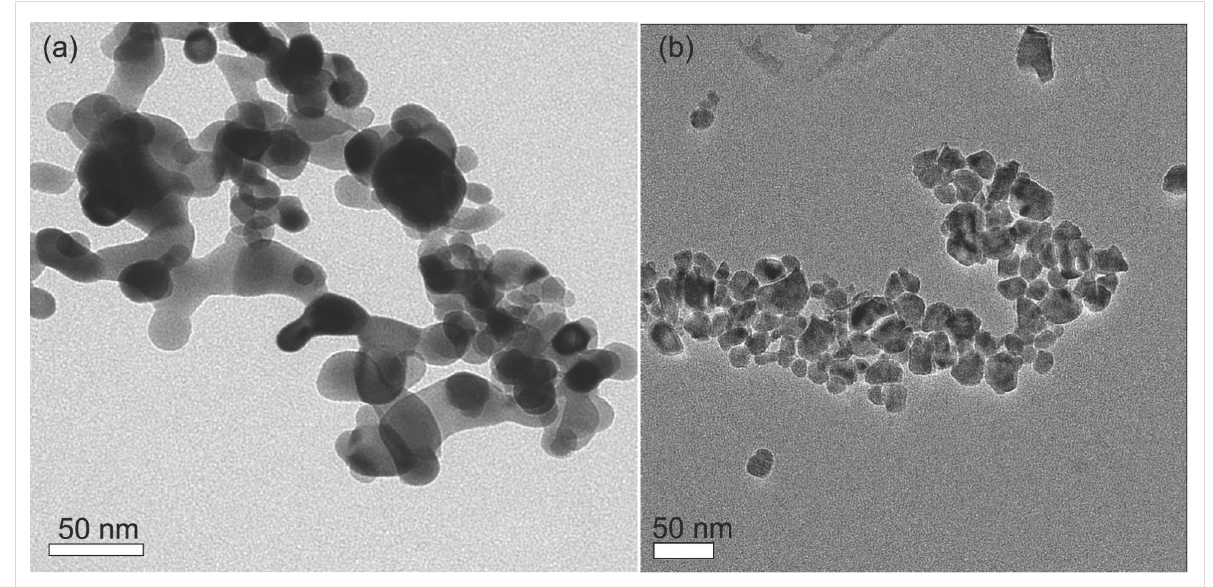
Figure 4: (a) TEM images of ZrO 2 , the reactant (b) HRTEM of the reaction